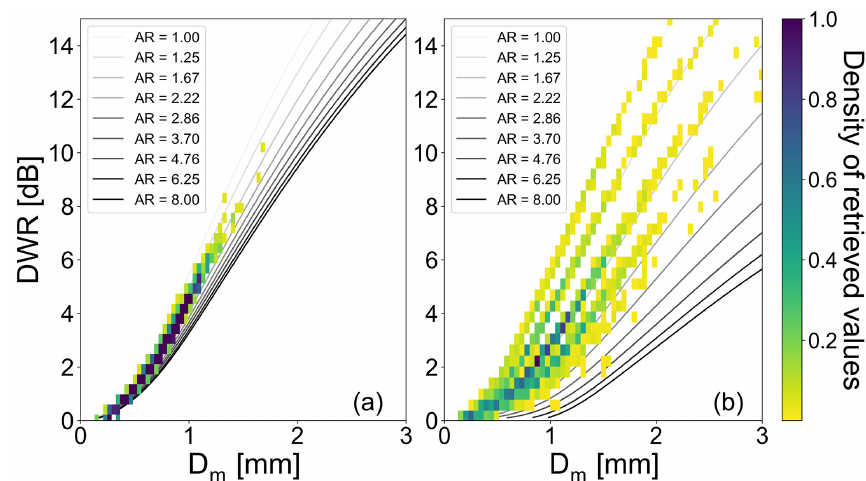
Figure 18. 2D density histograms between retrieved D m and measured DWR for different observation geometries. (a) Between the two radars θ C = θ Ka = 30 ◦ and (b) above the Ka-band radar θ C = 10 ◦ , with θ Ka = 90 ◦ . With gray lines the DWR and D m simulations are plotted for different values of AR using oblate ice spheroids with m(D max ) of aggregates.